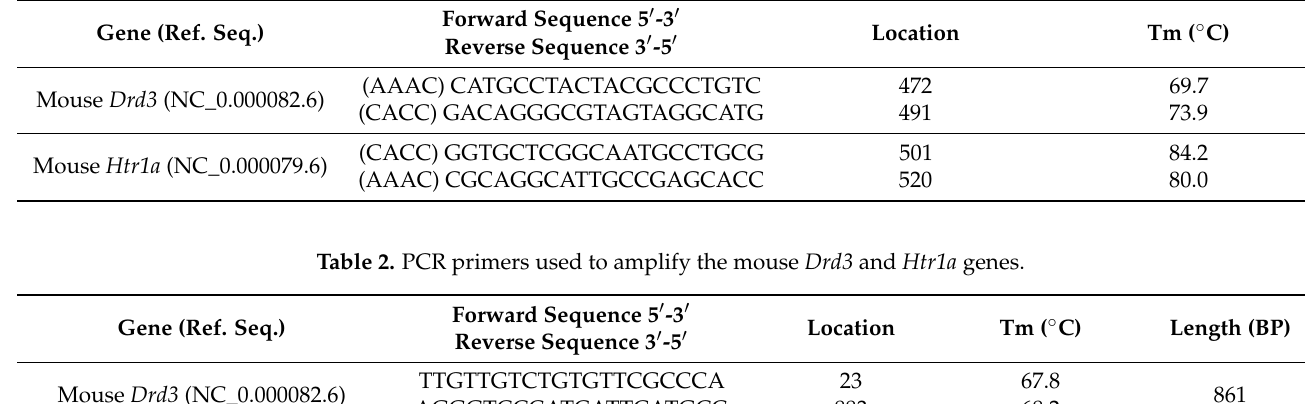
Table 1. Guide RNA (gRNA) primers used to target the mouse Drd3 and Htr1a genes with the CRISPR-Cas9 plasmid. Gene (Ref. Seq.)